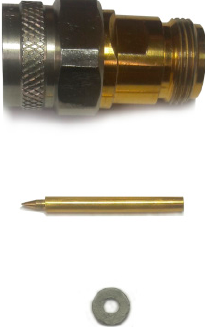
Figure 1. Coaxial transmission line (on top) with a central conductor (in the middle) and a composite sample (at the bottom) for microwave measurements.